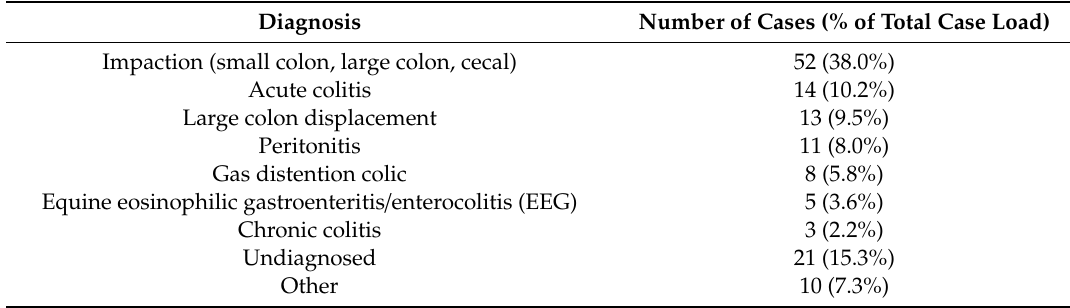
Table 2. Distribution of gastrointestinal diagnoses in